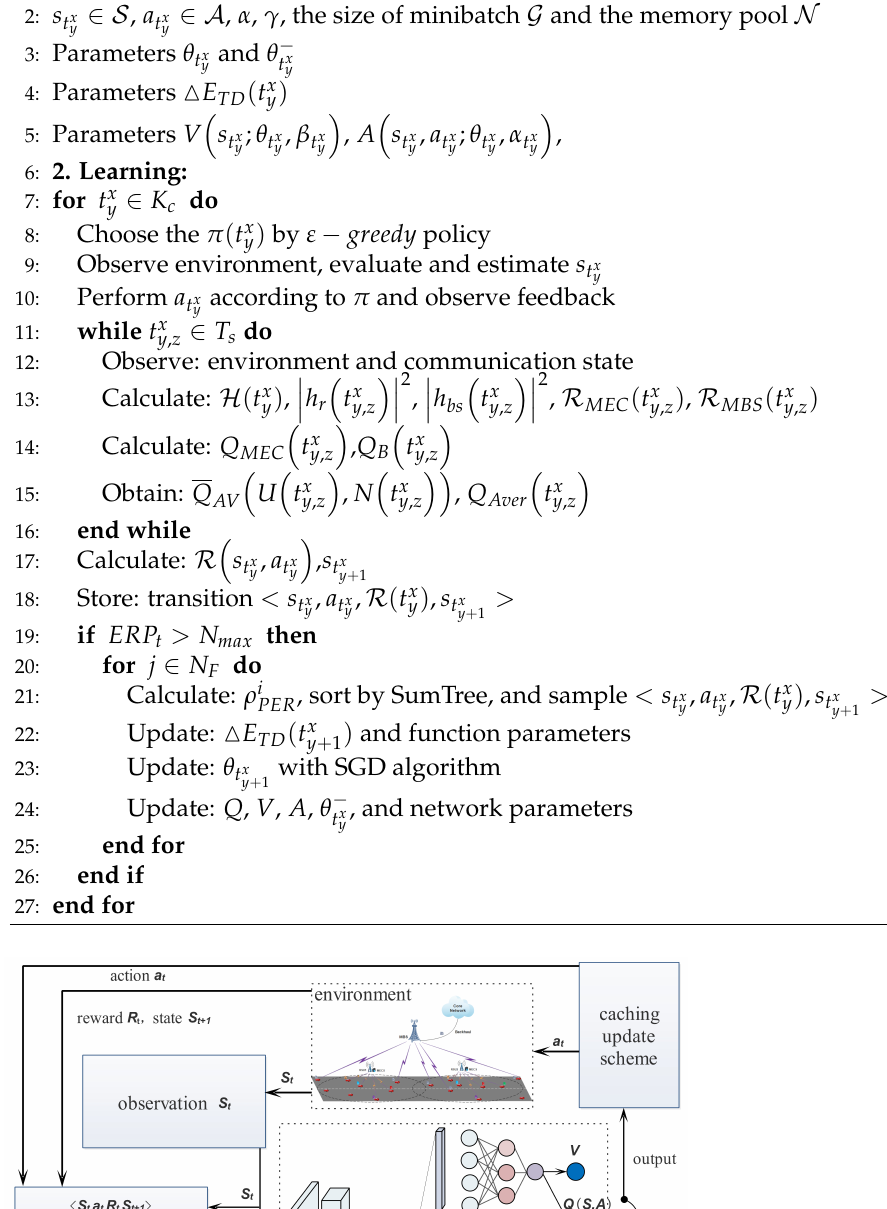
Algorithm 1 Prioritized experience replay Dueling Double DQN IoV QoE Caching (P3DVQC)